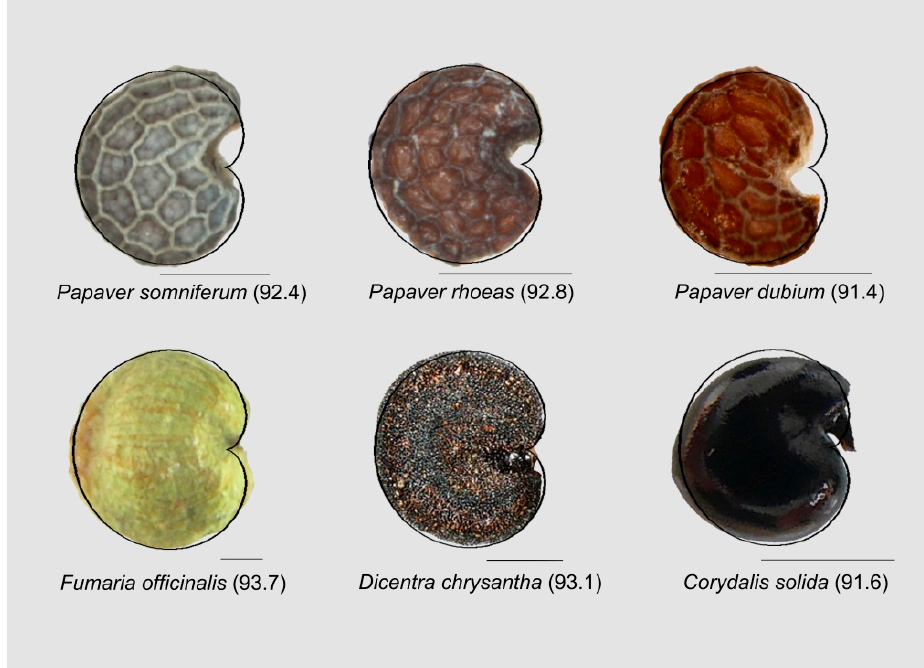
Figure 12. The cardioid is a model for seed shape description and quantification in species of the Papaveraceae. The values indicated correspond to J index in the images shown and do not represent mean values for each particular species. Bar equals 0.5 mm.